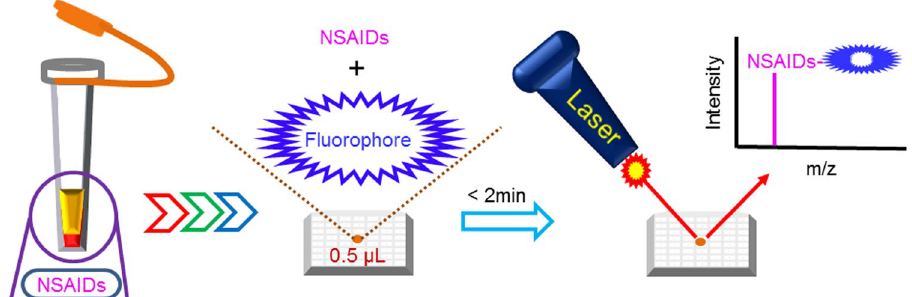
Figure 2. Schematic diagram of the MALDI-TOF MS method utilized to detect NSAIDs in human